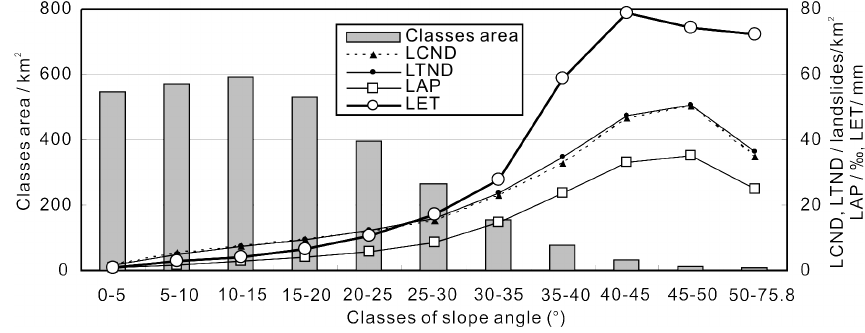
Figure 18. Relationships of co-seismic landslide abundances with slope angles.